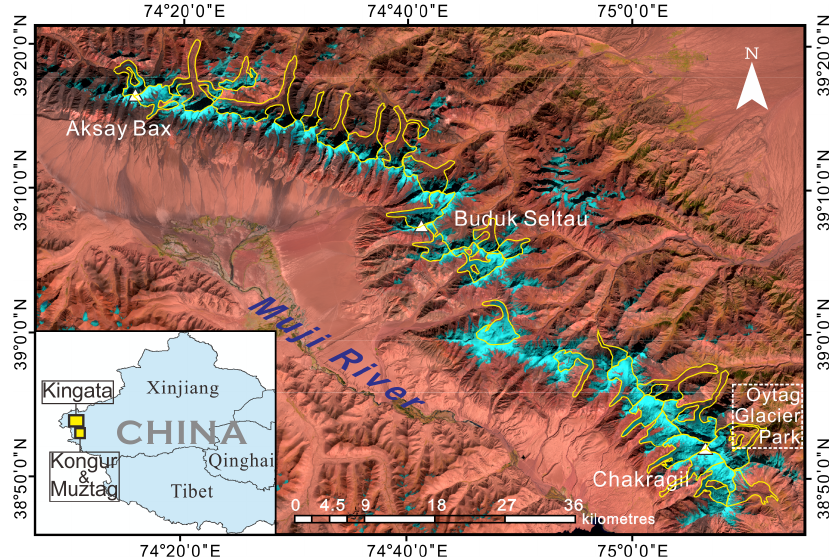
Figure 1. Landsat OLI image (bands 6, 5, and 4) of the Kingata Mountains acquired on 3 October 2014. Light blue areas represent bare ice, red-brown areas represent bare soil and rocks, and green areas represent grass or other vegetation. Glaciers with areas greater than 5km 2 are highlighted by yellow